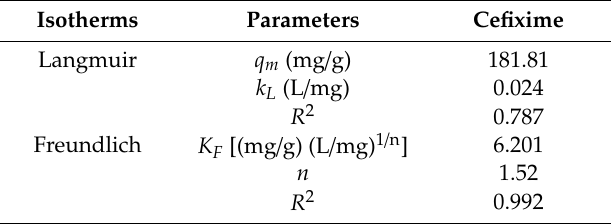
Table 2. Adsorption isotherm models and parameters for the adsorption of